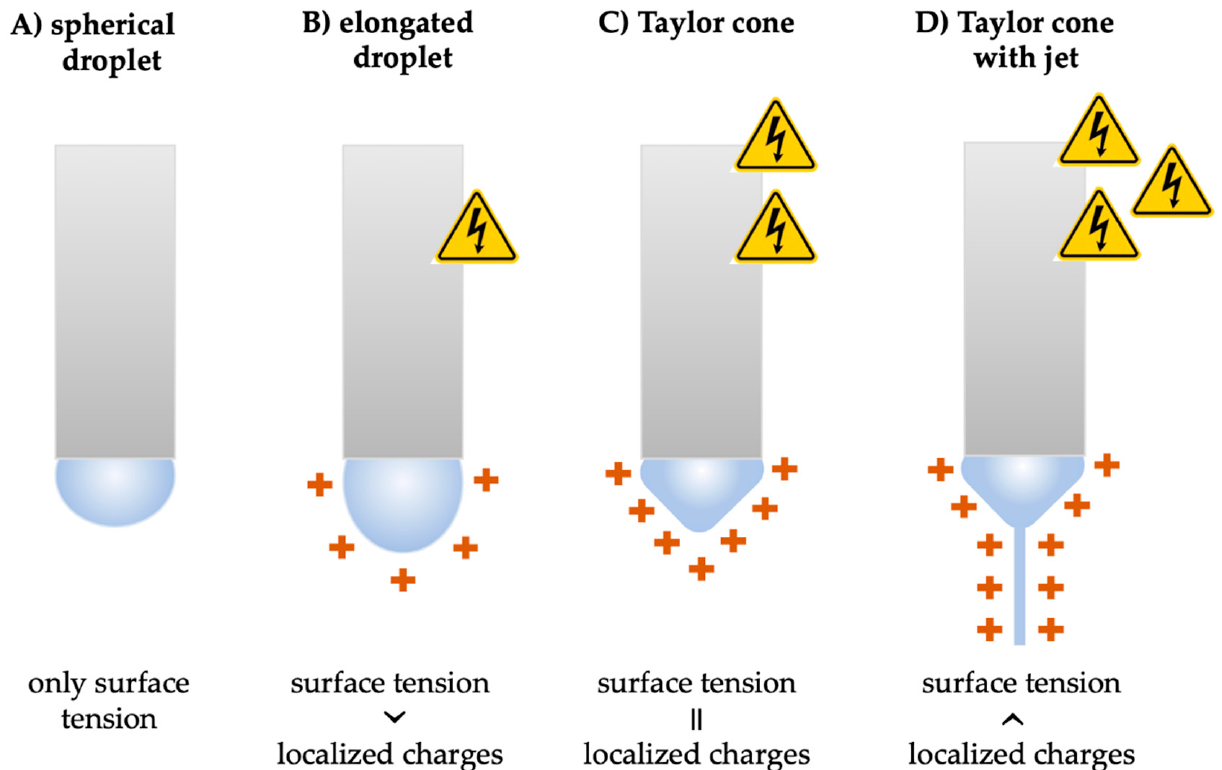
Figure 3. Schematic illustration of the Taylor cone formation as the high voltage increases. ( A ) Without the electric field, the pendant droplet is spherical in shape. ( B ) Localized charges are induced by the electrical force and elongate the droplet. ( C ) The formation of the Taylor cone occurs when the surface tension is balanced by the localized charges. ( D ) Ejection of the charged polymer jet from the Taylor cone due to the additional increase of the high voltage.